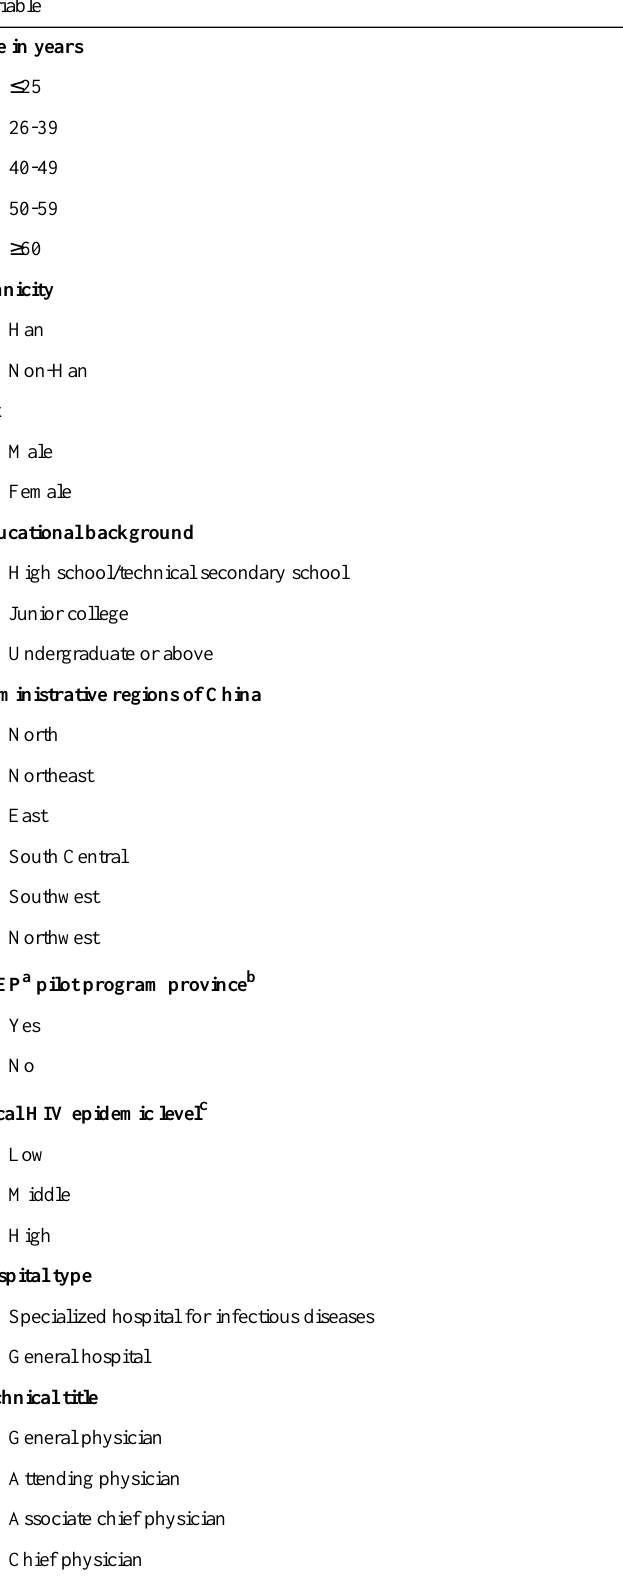
Table 1. Demographics and knowledge of HIV medical care providers in China